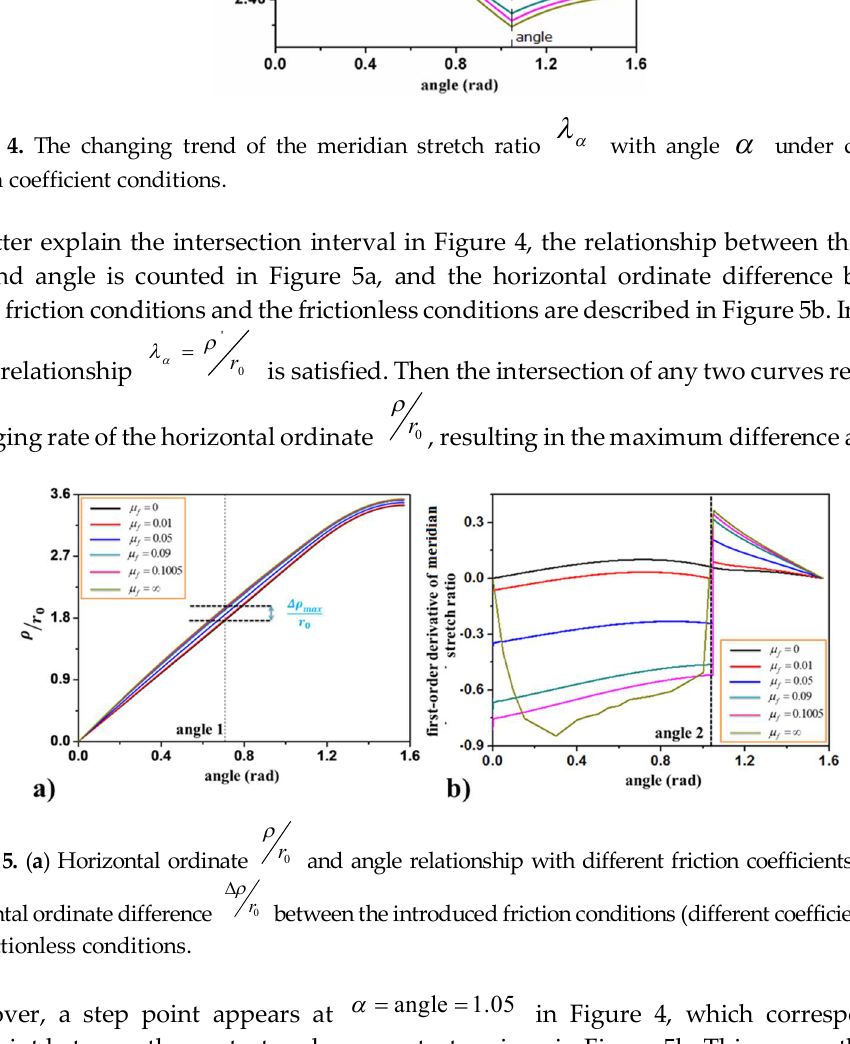
 r and angle relationship with different friction coefficients; ( b ) the   between the introduced friction conditions (different coefficients) and